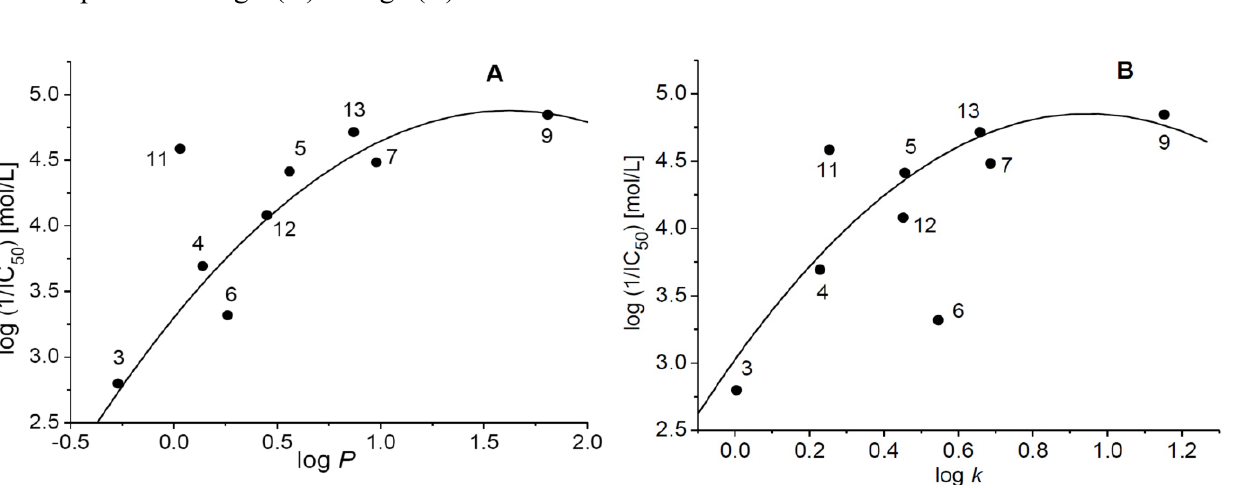
Figure 2. Dependence of PET-inhibiting activity on lipophilicity of studied compounds expressed as log P ( A ) or log k ( B